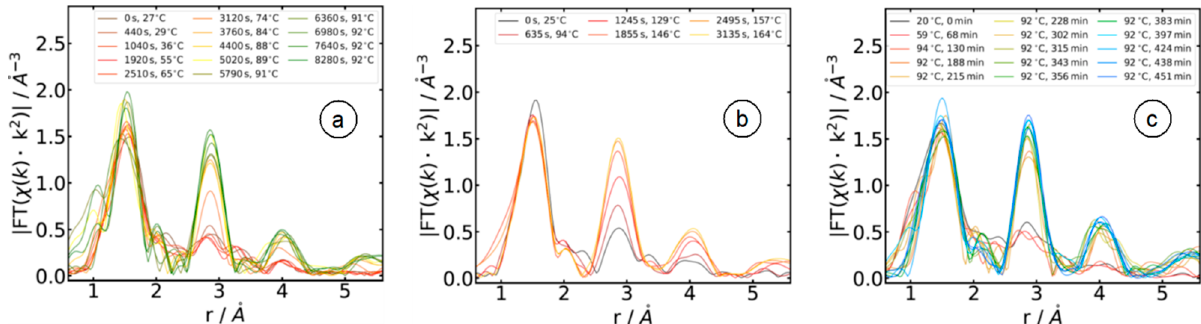
Figure 4. Magnitude of the k 2 -weighted X-ray absorption fine structures χ (k)*k 2 for the indicated times and temperatures (k-range for the FTs: 1.2 Å − 1 < k < 11.0 Å − 1 , Kaiser–Bessel window functions). The peaks at ca. 1.5 Å belong to the Zn-O interactions, the peaks at ca. 2.9 Å are due to Zn-Zn bonds, respectively, and peaks at ca. 4 Å belong to multiple scattering events with larger path distances involving zinc and oxygen backscatters. ( a ) The reaction of Zn(acac) 2 solution in 10 − 3 M NaOH (sample A); ( b ) reaction of Zn(acac) 2 solution in 1-octanol (sample O); and ( c ) reaction of Zn(acac) 2 solution in distilled water (sample W).